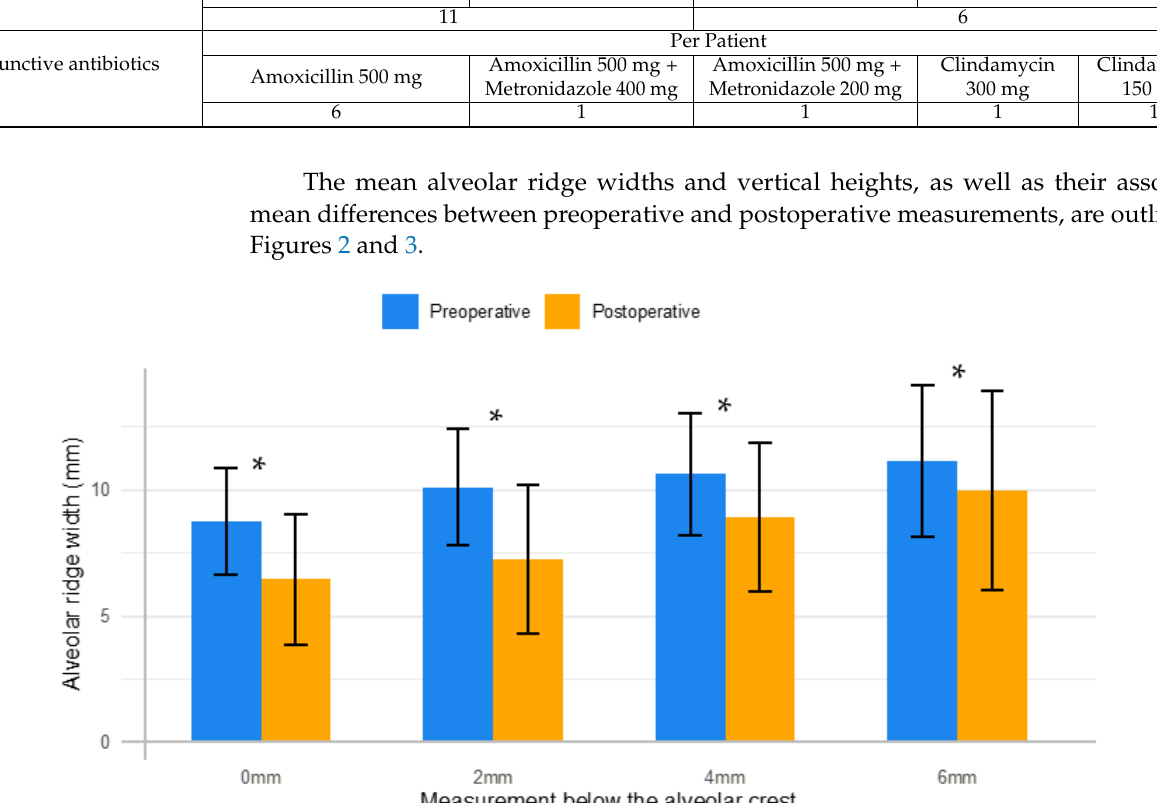
Figure 3. Alveolar ridge height measurements. Mean preoperative (blue) and postoperative (or- ange) crestal height measurements are shown for both the buccal and palatal/lingual aspects of the alveolar crest. * Statistically significant mean difference ( p < 0.05). As the normality assumptions were satisfied, parametric tests were applied. There was a mean reduction in the thickness of the alveolar ridge width for all four measure- ments below the height of the crest (0 mm, 2 mm, 4 mm and 6 mm). The mean differences were 2.30 ± 1.35 mm, 2.84 ± 2.48 mm, 1.70 ± 1.65 mm and 1.16 ± 1.28 mm at 0 mm, 2 mm, 4 mm and 6 mm below crestal level, respectively. These mean differences for the changes in the alveolar ridge width were statistically significant ( p < 0.05). For alveolar ridge height, a statistically significant mean difference of 1.28 ± 1.46 mm was found between preoperative and postoperative measurements pertaining to the pal- atal/lingual aspect of the alveolar crest, as seen in Table 2. However, a marginally signifi- cant mean difference of 0.79 ± 1.72 mm was found for changes in the buccal aspect of the